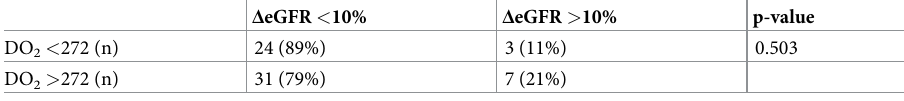
Table 2. Crosstab analysis of the relation between both DO 2 groups and Δ eGFR groups.